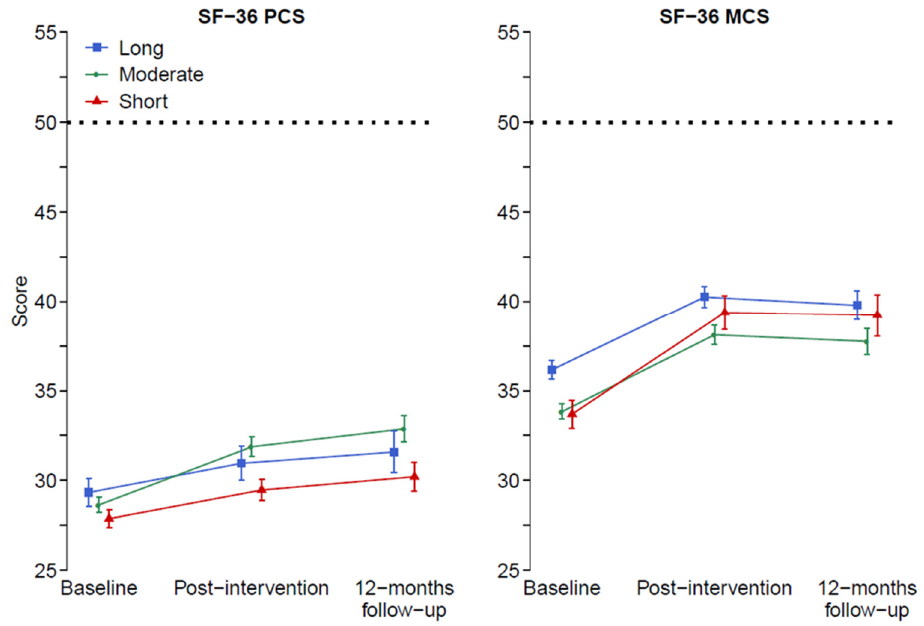
Figure 2. Change of health-related QoL from baseline to post intervention and 12 months follow-up, measured by SF-36 Physical Component Summary (PCS), Mental Component Summary (MCS). High values indicate better status. In the model, adjustment was made for baseline status and treatment days / week. Note: graphs show unadjusted baseline values, while statistical analysis was controlled for differences at baseline. Dashed lines indicate norm value for general population.